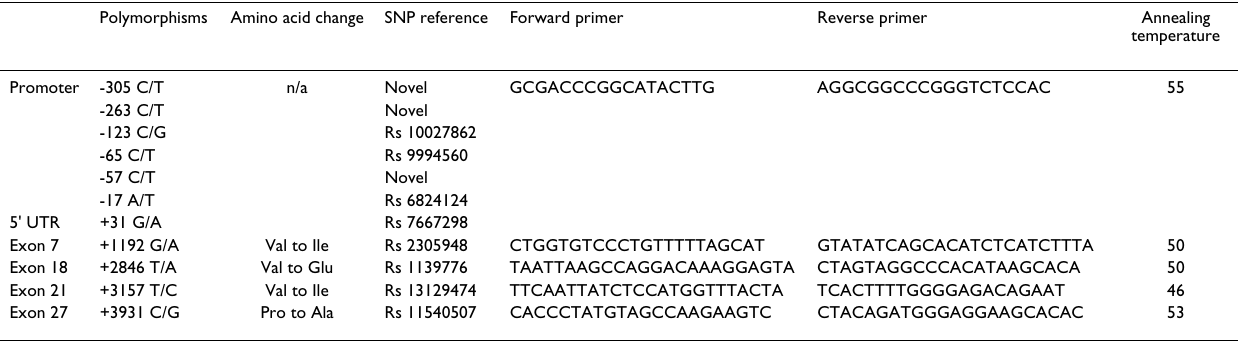
Table 1: Primers used to amplify regulatory and exonic regions of the VEGFR2 gene, and polymorphisms present. Polymorphisms Amino acid change SNP reference Forward